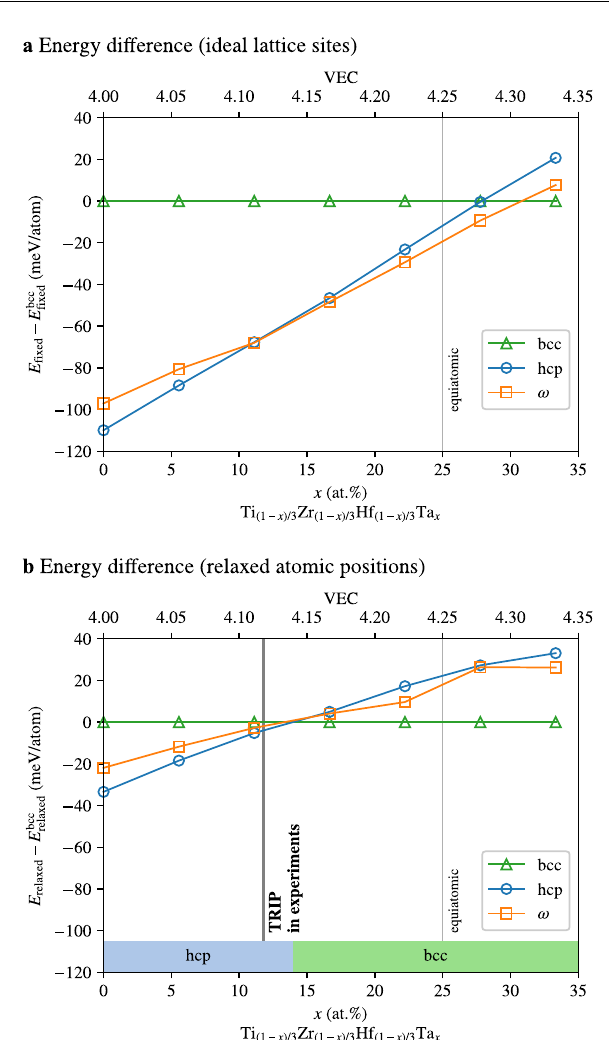
other compositions (orange circles). This strengthens the argu-